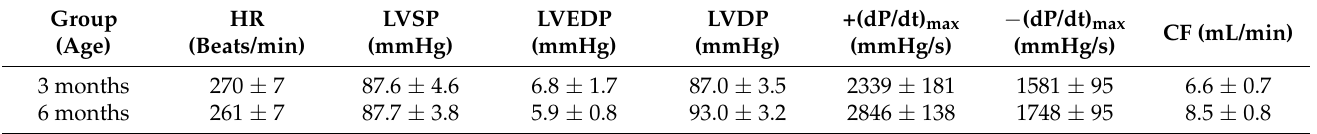
Table 2. Pre-ischemic values of hemodynamic parameters of isolated rat